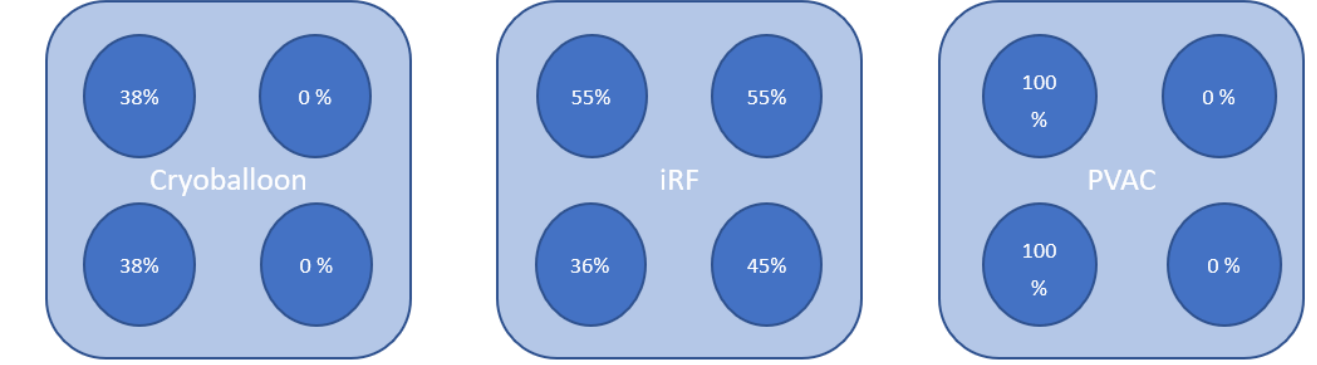
Figure 2. Schematic left anterior oblique view of the LA with the percentage of PV reconnections in the LAT patients.